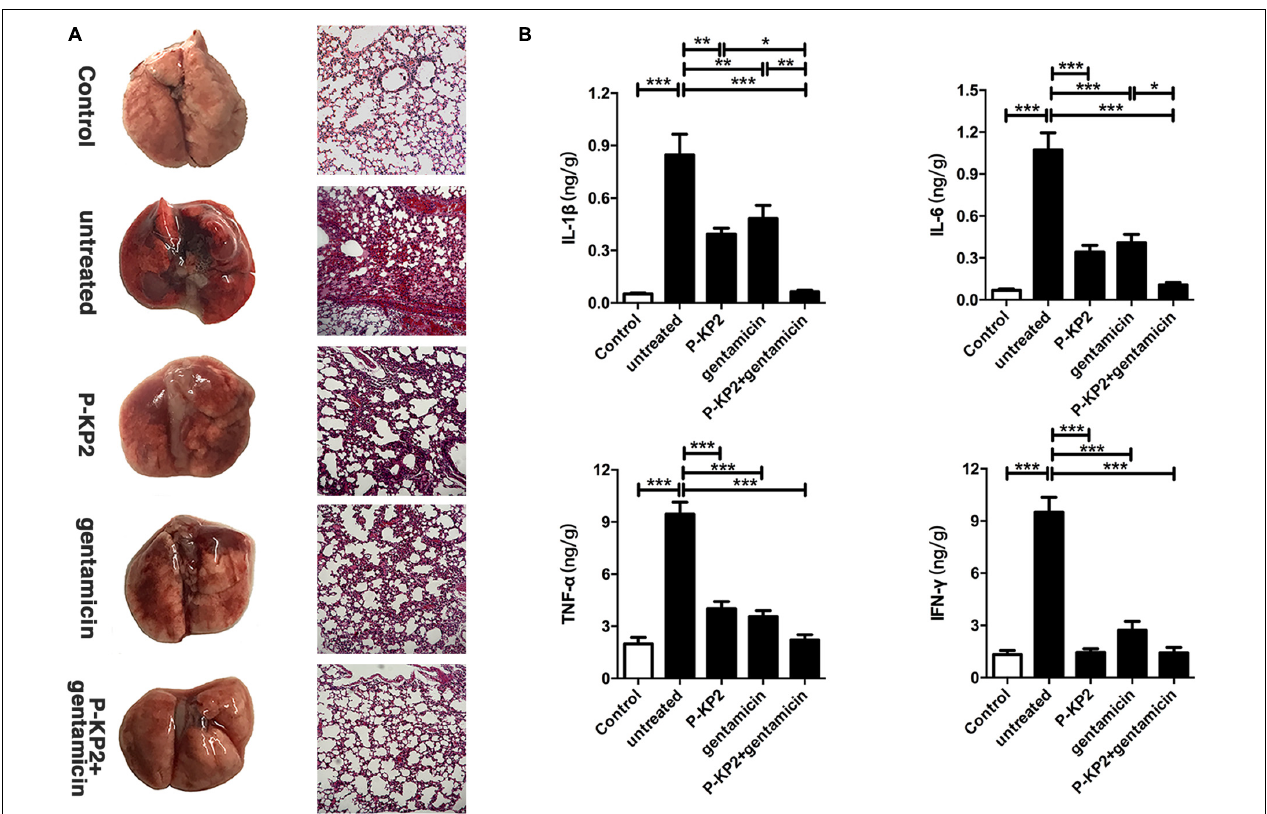
FIGURE 7 | Pathological changes and cytokine levels of mice in different groups. All the mice were challenged intranasally with 1.0 × 10 9 CFU/mouse of K. pneumoniae W-KP2. After 1 h post infection, they were intranasally treated with P-KP2 (1.0 × 10 9 PFU/mouse), gentamicin (1.5 mg/kg), or phage-antibiotic combination (gentamicin was administered intranasally at 30 min after P-KP2 administration), respectively. The untreated group was administered with PBS under the same conditions. (A) Pathological observation. At 72 h after W-KP2 infection, the lungs of the euthanized mice in each group were photographed after careful removal, and the sections of left lung tissues were stained with H&E (magnification, × 100). Lung tissue of healthy mice was served as a control. (B) Determination of cytokine levels. At 72 h after W-KP2 infection, cytokine levels (IL-1 β , IL-6, TNF- α , and IFN- γ ) in lung homogenates of mice treated with phage P-KP2, gentamicin, or phage-antibiotic combination were determined. Lung tissue homogenates of healthy mice were served as controls. *, **, and *** represent significant differences at P < 0.05, P < 0.01, and P < 0.001, respectively. Data represent the mean ± SEM of triplicate